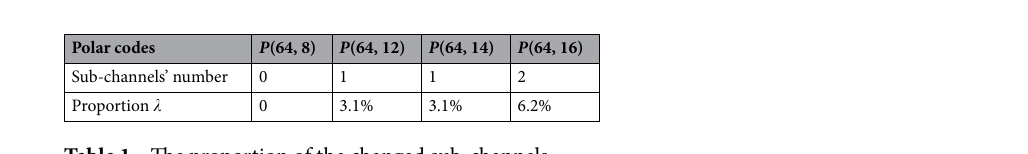
Table 1. The proportion of the changed